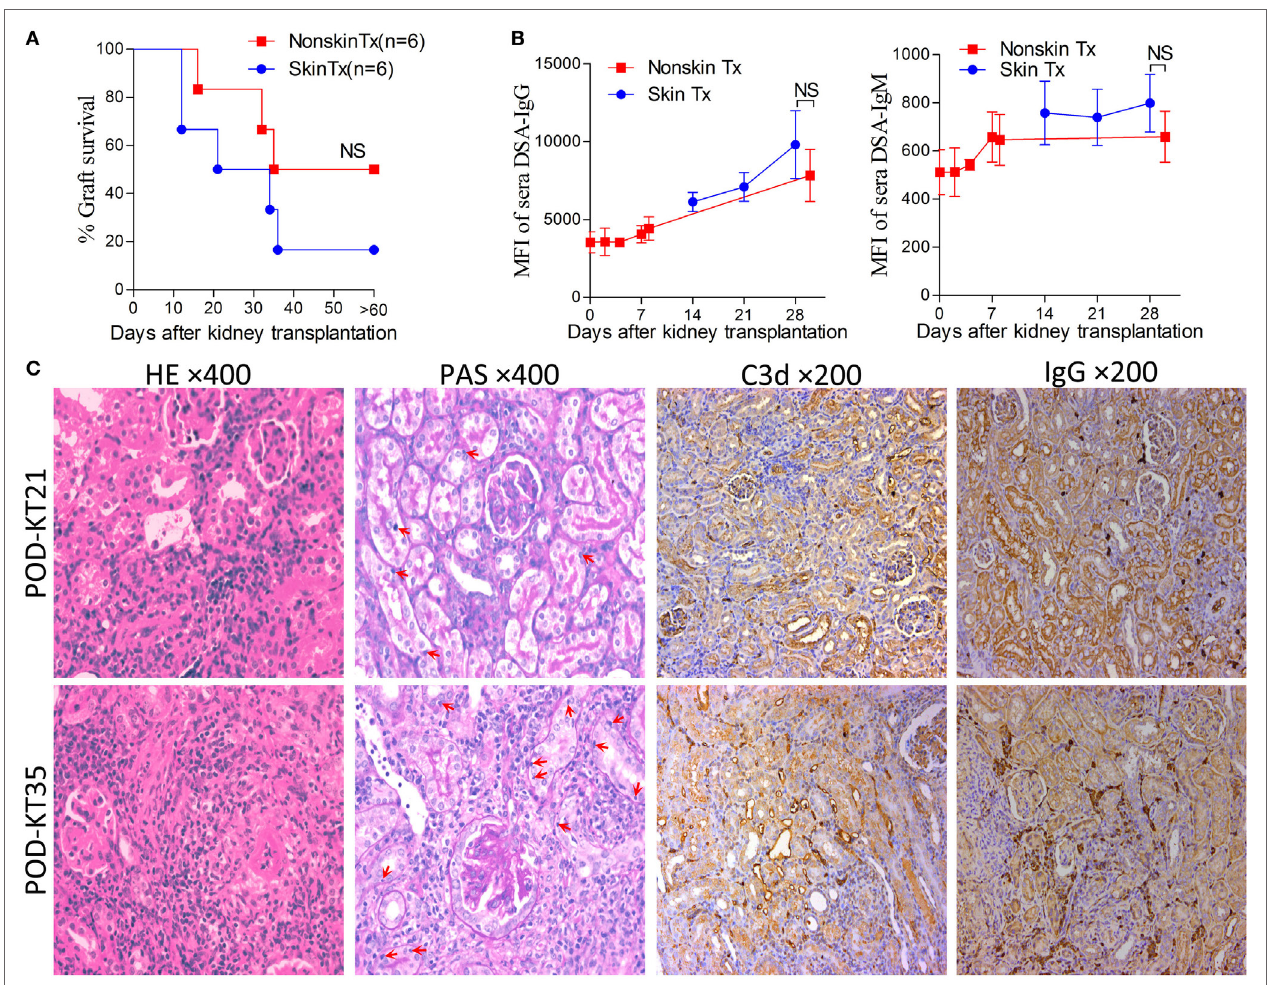
FigUre 5 | Skin priming after kidney transplant does not promote donor-specific antibody (DSA) generation strongly. C57BL/6 donor skin grafts were transplanted into Balb/c recipient mice on day 7 after the Balb/c mice received kidney grafts from C57BL/6 mice (skin Tx group). Balb/c mice that received C57BL/6 donor kidneys without subsequent skin grafting acted as controls (nonskin Tx group). (a) Donor-matched skin grafts after kidney transplantation decreased the renal graft survival time but not strongly within 60 days. (b) Recipient serum DSA levels were detected by flow cytometry and expressed as mean fluorescence intensity (MFI). The DSA data present the mean ± SD of at least six independent samples. Donor-matched skin grafts after kidney transplantation accelerated DSA generation but not strongly within 30 days. (c) Sections of kidney grafts after transplantation were stained with hematoxylin and eosin (H&E) and periodic acid-Schiff (PAS), × 400; and for the deposition of IgG and C3d, × 200. Histological features of interstitial inflammation and tubulitis (arrows) in cell-mediated rejection and deposition of IgG and C3d in peritubular capillaries could be identified on day 21 (KT21) and 35 (KT35) post kidney transplantation in the skin Tx group. NS, no significant